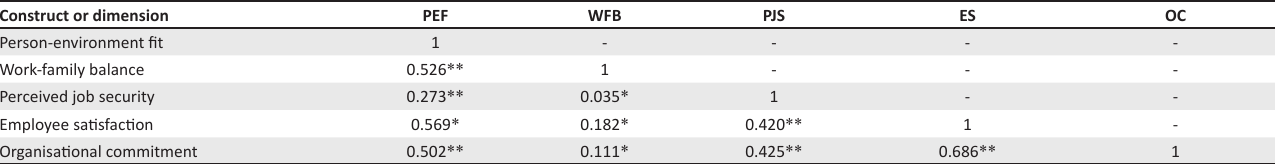
TABLE 4: Correlation analysis – extracted work-related factors, employee satisfaction and organisational commitment. Construct or dimension